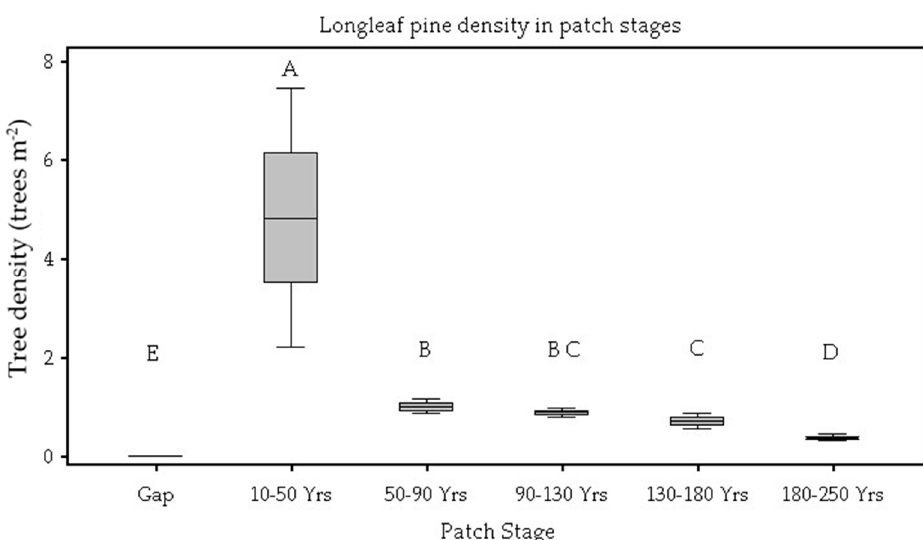
Figure 1. Mean longleaf pine tree density (trees m − 2 ) for plots in each patch stage ( n = 10). Boxes represent plot distribution within one standard deviation of the mean (box centerline). Error bars indicate standard error and shared letters indicate non-significant differences between patch stages.